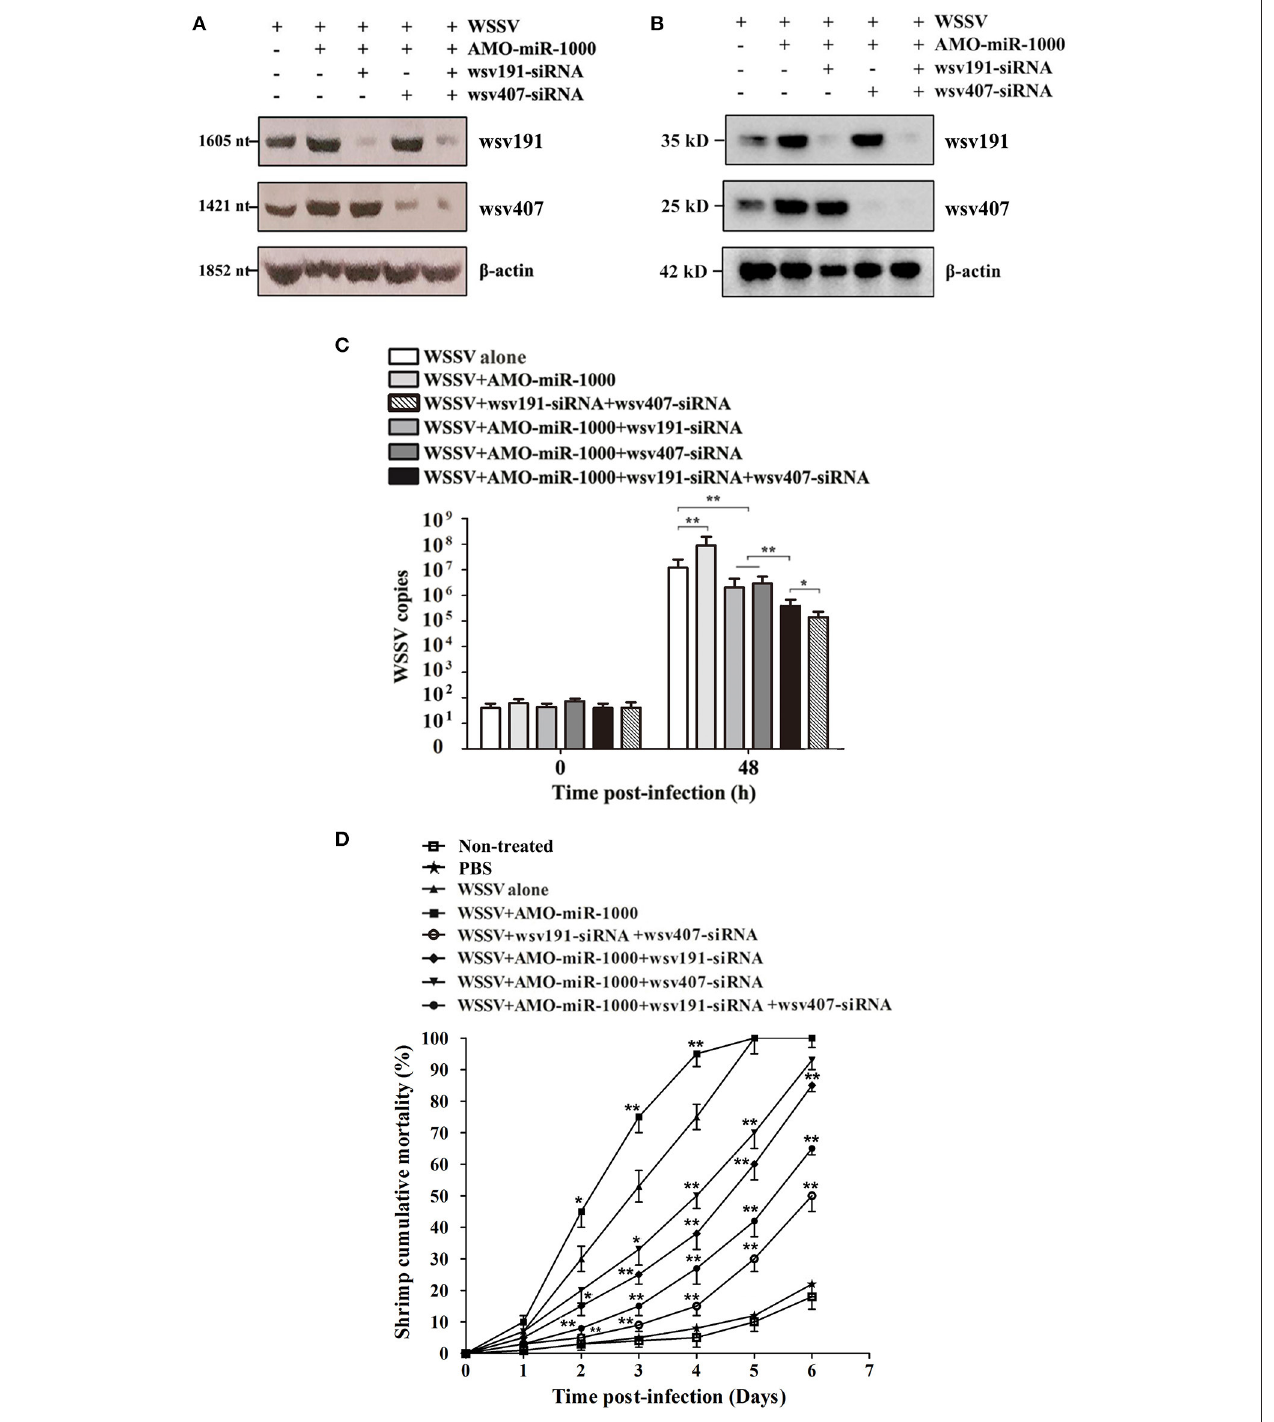
FIGURE 4 | Suppression of WSSV infection by miR-1000 via targeting wsv191 and wsv407 in vivo . (A) Northern blot analysis of wsv191 and wsv407 mRNA levels in shrimp. Shrimp were injected with WSSV, AMO-miR-1000, wsv191-siRNA and/or wsv407-siRNA. Forty 8h later, shrimp hemocytes were subjected to Northern blot. (B) Western blot analysis of wsv191 and wsv407 protein levels. At 48h after injection of WSSV, AMO-miR-1000, wsv191-siRNA, and/or wsv407-siRNA, shrimp hemocytes were analyzed with Western blot analysis to detect the wsv191 and wsv407 proteins. (C) Influence of miR-1000 silencing, wsv191 silencing or/and wsv407 silencing on WSSV infection in shrimp. The WSSV copy number of shrimp with different treatments was evaluated using quantitative real-time PCR. Numbers indicated the time points post-infection (** p < 0.01). (D) Cumulative mortality of shrimp. The mortality of shrimp was examined daily (* p < 0.05; ** p < 0.01).